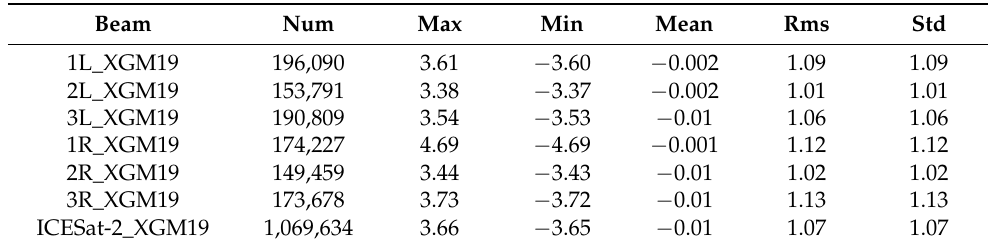
Table 8. Statistics of differences between the along-beam DOVs and the XGM2019e_2159-DOV model (Unit: arc_sec).